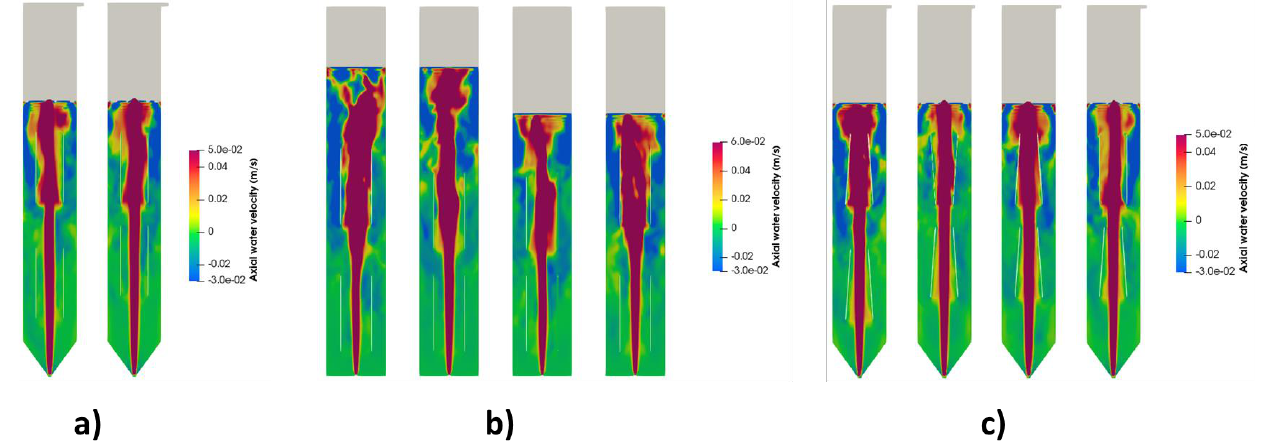
Figure 10. Axial velocity at 60 s of simulation ( a ) Case 1 and 2, ( b ) Case 3, 4, 5, 6, and ( c ) Case 7, 8, 9, 10. On geometries 1 and 2 (Figure 10a), it can be seen that the downcomer enters the bottom of the draft tube. This can also be seen on most of the geometries on Figure 10b. This counterflow has been eliminated by transforming the bottom draft tube into a funnel (reducing the diameter of the top part of the draft tube) as shown in Figure 10c. To represent the flow movement the axial water velocity of geometry 9 is captured every 5 s in Figure 11, colored with a maximum riser velocity of 0.05 m/s and a maximum downcomer velocity of 0.03 m/s.